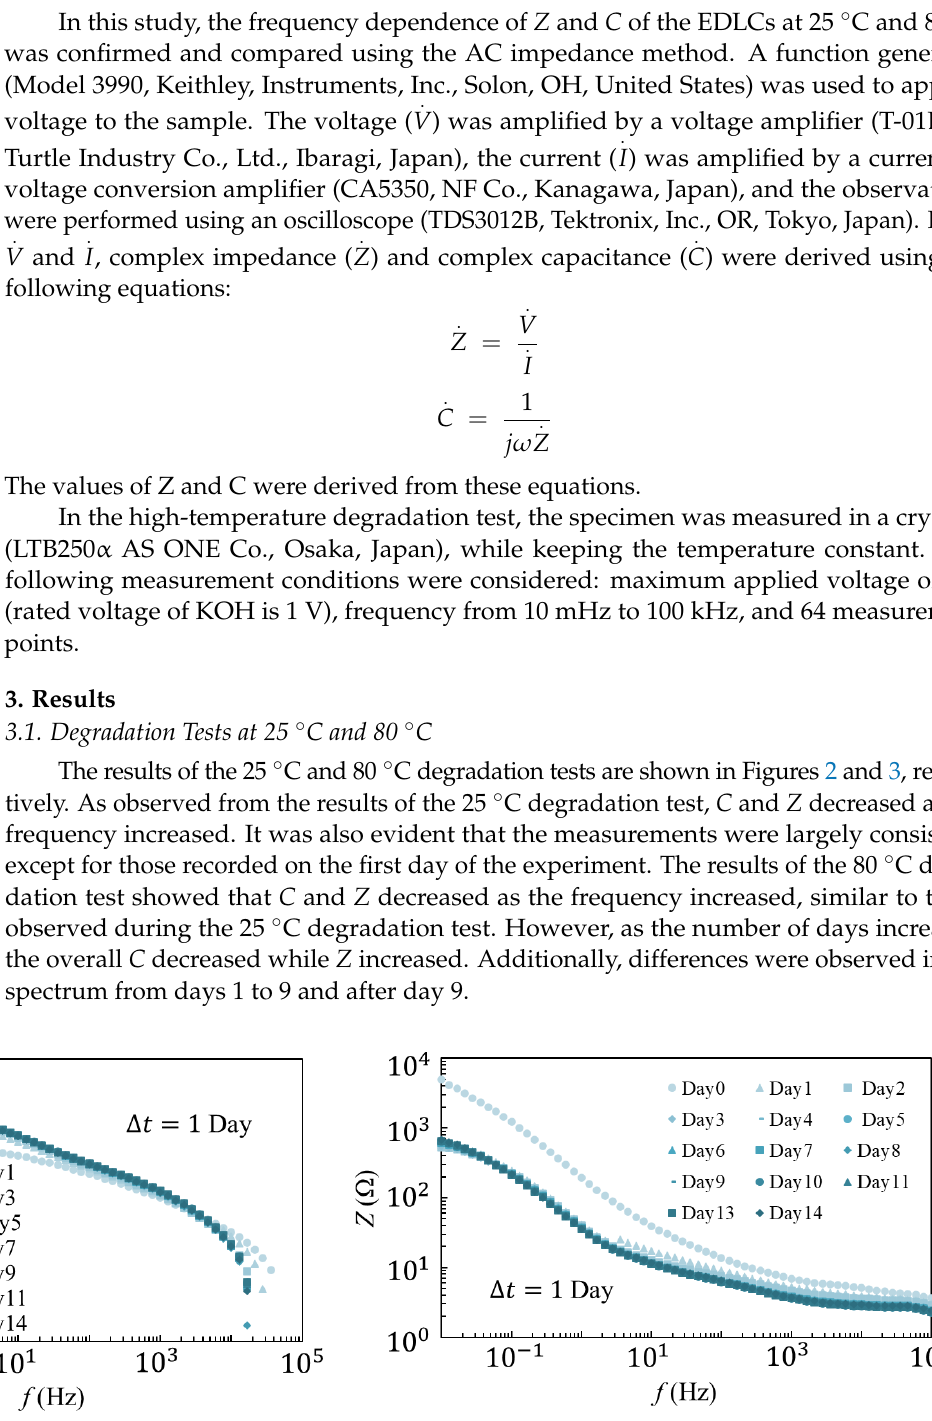
until day 5 (black markers); however, the values were approximately constant after day